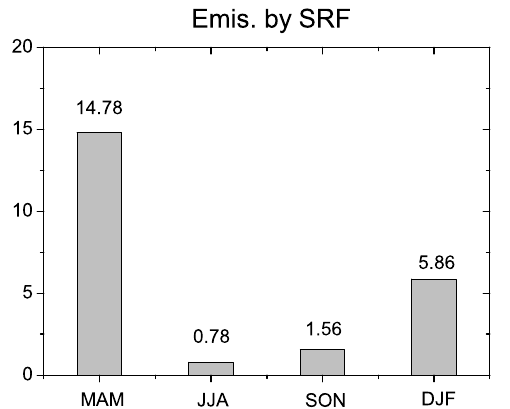
Figure 12. Seasonal changes in dust emissions (Tg per sea- son) induced by the dust-in-snow radiative forcing (SRF) in- cluding March–April–May (MAM), June–July–August (JJA), September–October–November (SON) and December–January– February (DJF).